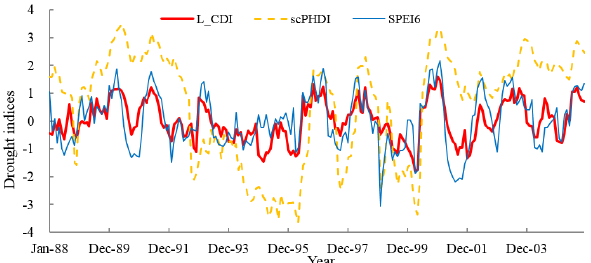
Figure 3. Temporal variations of the long-term CDI and its compo-